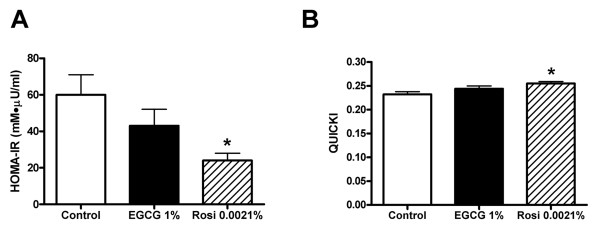
Changes in insulin resistance after 10 weeks of treatment with EGCG or rosiglitazone. Peripheral insulin sensitivity was assessed in control db/db mice and db/db mice receiving a diet supplemented with 1% (w/w) EGCG or 0.0021% (w/w) rosiglitazone (Rosi) for 10 weeks. Insulin resistance was evaluated by two different means: Shown in A is homeostasis model assessment-estimated insulin resistance (HOMA-IR) that was calculated as fasting glucose (mM) * fasting insulin (μU/ml)/22.5. Quantitative Insulin Sensitivity check (QUICKI) is shown in B and was calculated as 1/[log ((fasting glucose (mg/dl) + (fasting insulin (μU/ml))]. Bars represent mean ± SEM for 9 mice in each group. * denotes P < 0.05 for a chance difference vs controls using one-way ANOVA in conjunction with Dunnett's multiple comparison test.